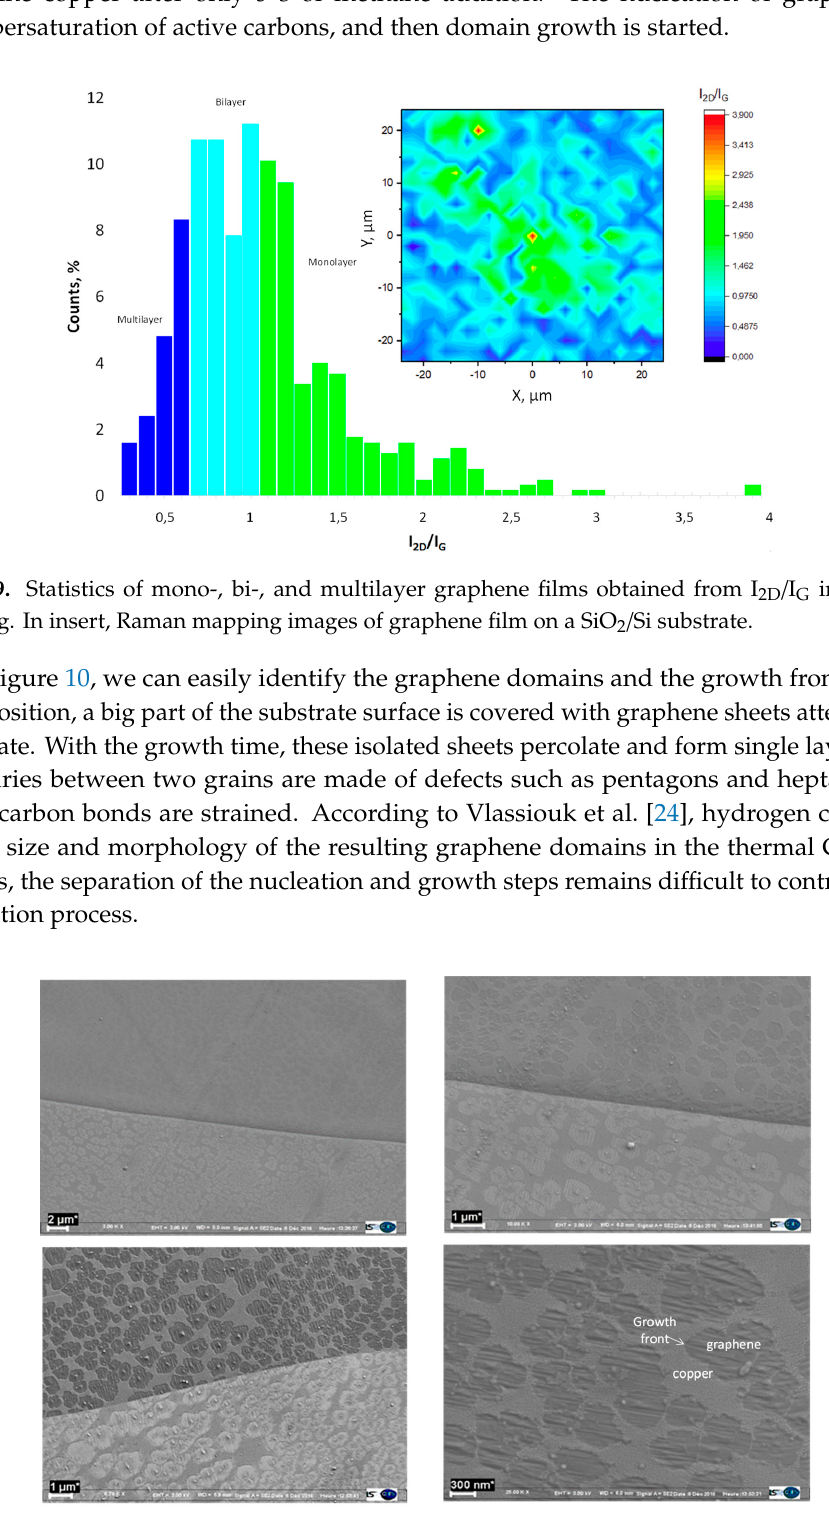
Figure 8. Raman spectroscopy in confocal mode in air with the backscattering configuration using